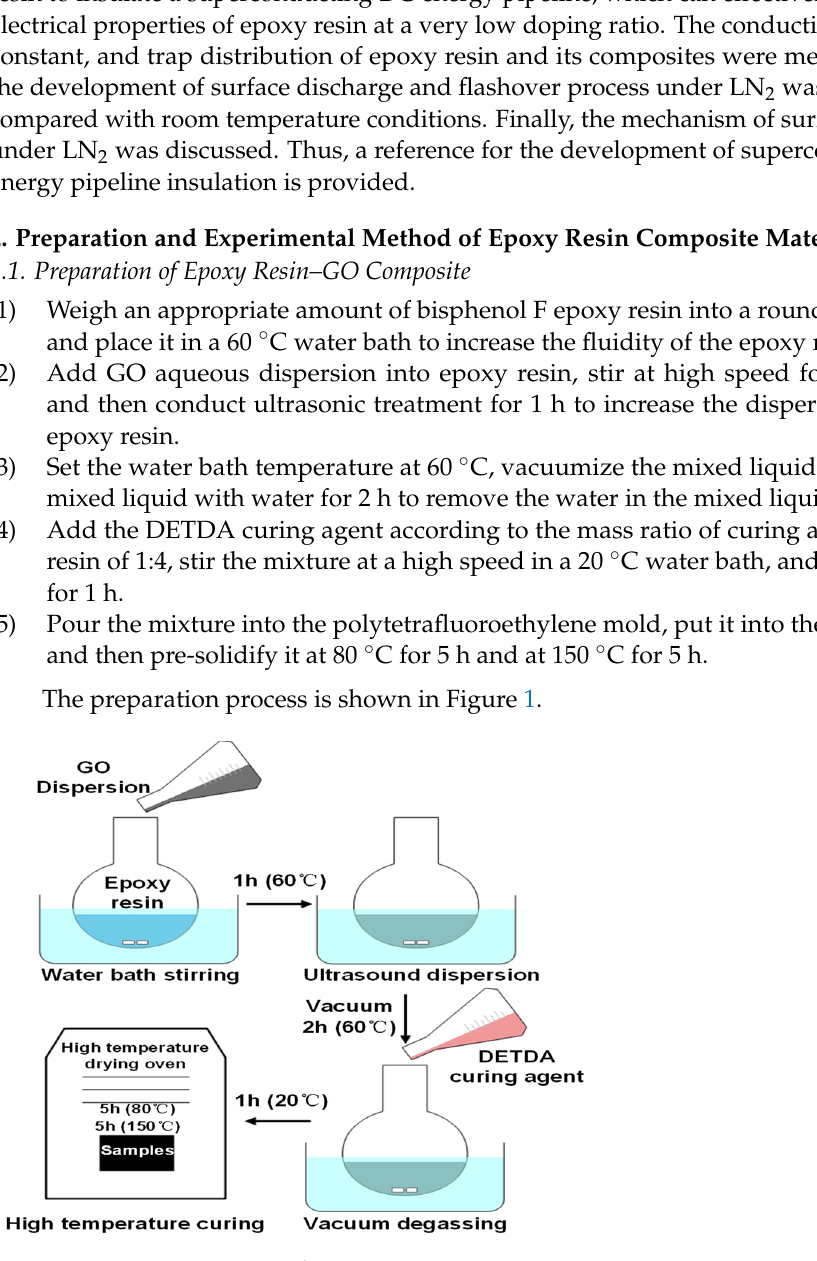
Figure 1. Preparation process of epoxy resin–GO nanocomposites. The epoxy resin-type GY285 bisphenol F (DGEBF) and the amine curing agent di-